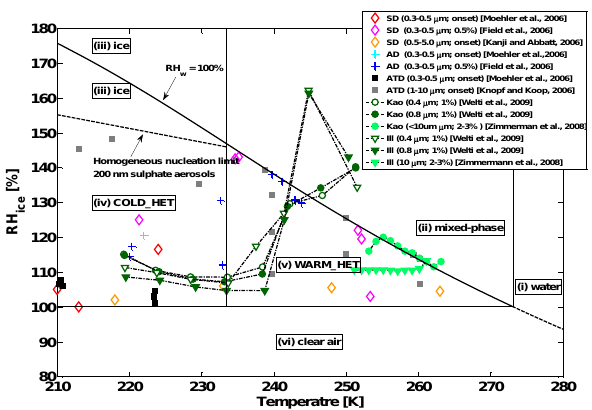
Fig. 8. Phase diagram as in Fig. 4, showing relative humidities mea- sured in laboratory experiments addressing heterogeneous ice nu- cleation on naturally occurring, pure and refined mineral substrates (SD = Saharan Dust; AD = Asian Dust; ATD = Arizona Test Dust; Kao = Kaolinite; Ill = Illite) and using a number of techniques. The legend indicates the type and diameter of the particles studied (re- ferring to a size distribution in the work of M¨ohler et al., 2006 and Field et al., 2006) and the criterion for the RH i recorded in or de- rived from the experiments (either for freezing onset or a minimum percentage of ice-activated particles, as indicated). Techniques rep- resented include AIDA chamber (M¨ohler et al., 2006; Field et al., 2006), continuous flow diffusion chamber (Welti et al., 2009), and environmental scanning electron microscope (Zimmermann et al., 2008). Only single-nucleation-event data from Field et al. (2006) are